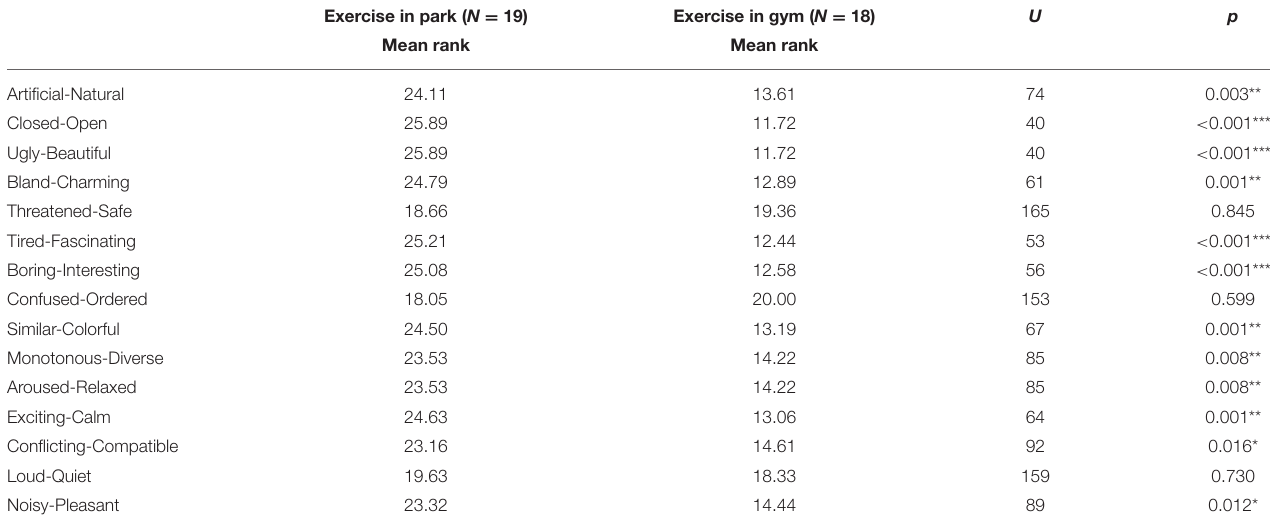
TABLE 7 | Comparison of environmental perceptions for different settings while walking fast. Exercise in park ( N = 19) Exercise in gym ( N = 18) U